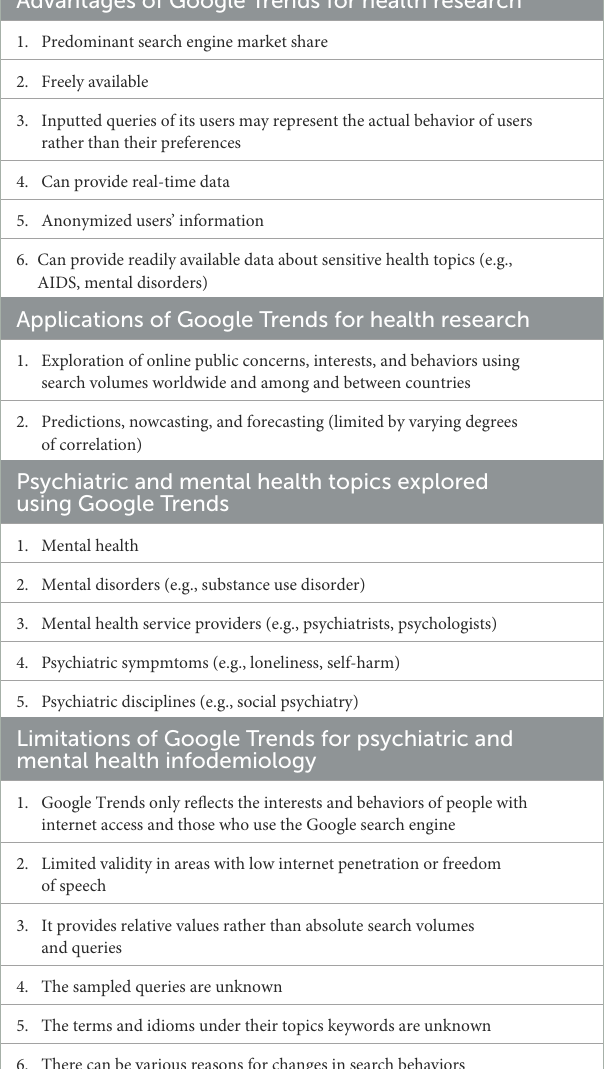
TABLE 1 Advantages, applications, topics, and limitations of Google Trends for health research and psychiatric and mental health infodemiology.